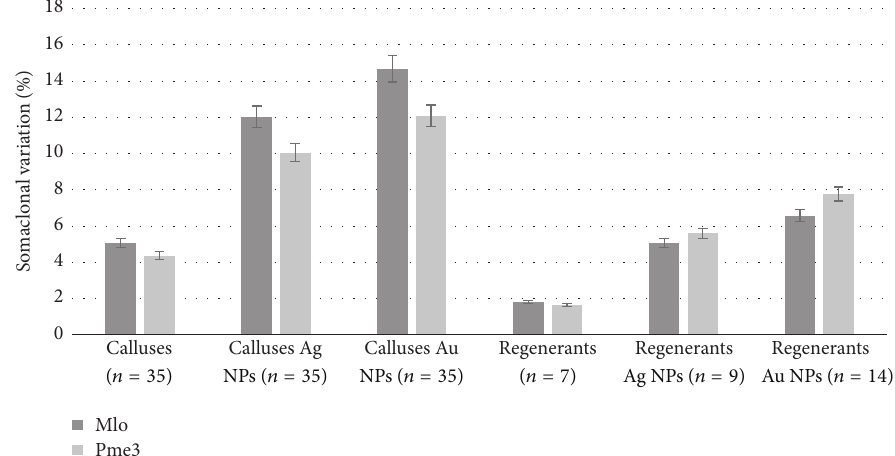
Figure 1: Somaclonal variation in two resistance genes in all development stages of L. usitatissimum. Means ± SD and significant difference 𝑃 < 0.05 were indicated, respectively, from the control. The SV was expressed as the percentage of the differences in the nucleotide sequence in comparison with reference sequence of donor